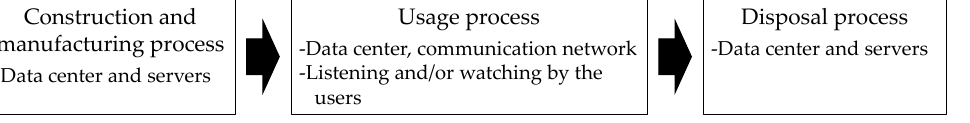
Figure 1. System boundary.